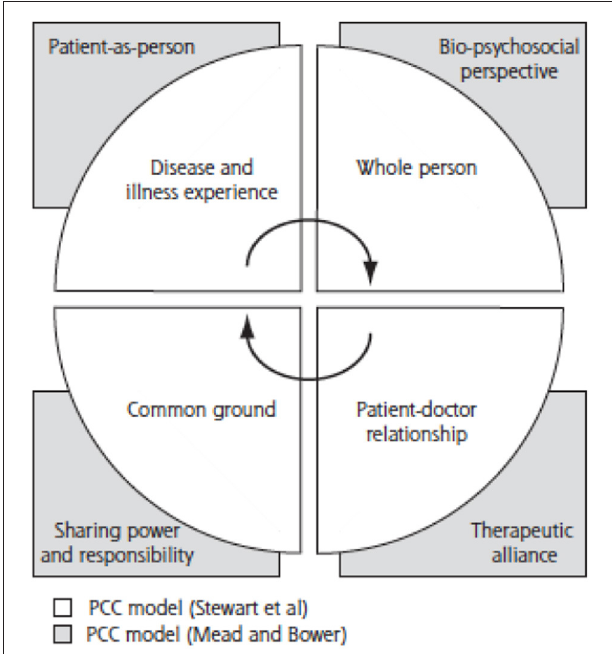
FIGURE 3 | Conceptual Framework of Patient-Centered Care